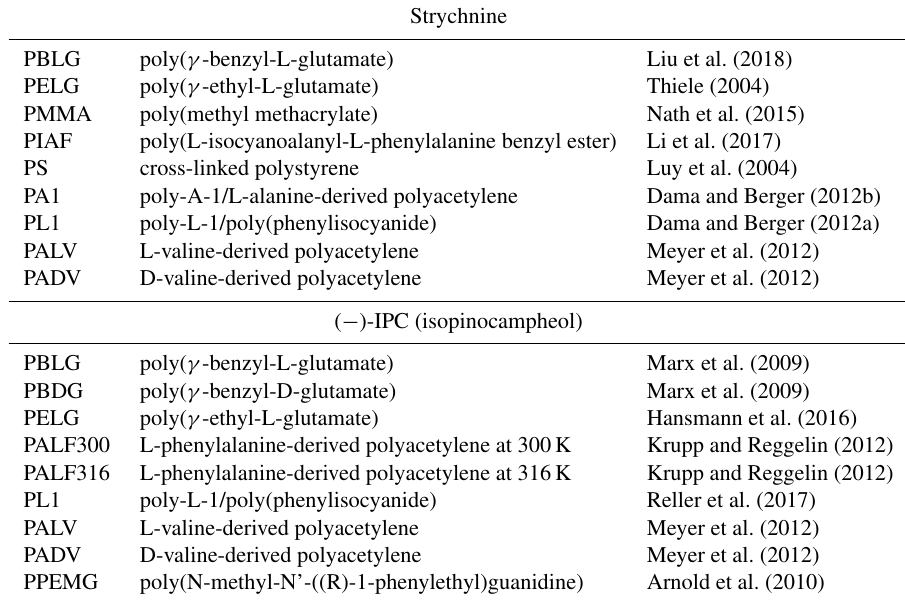
Table 1. Selected alignment media for which experimental RDCs of strychnine and ( − )-IPC were